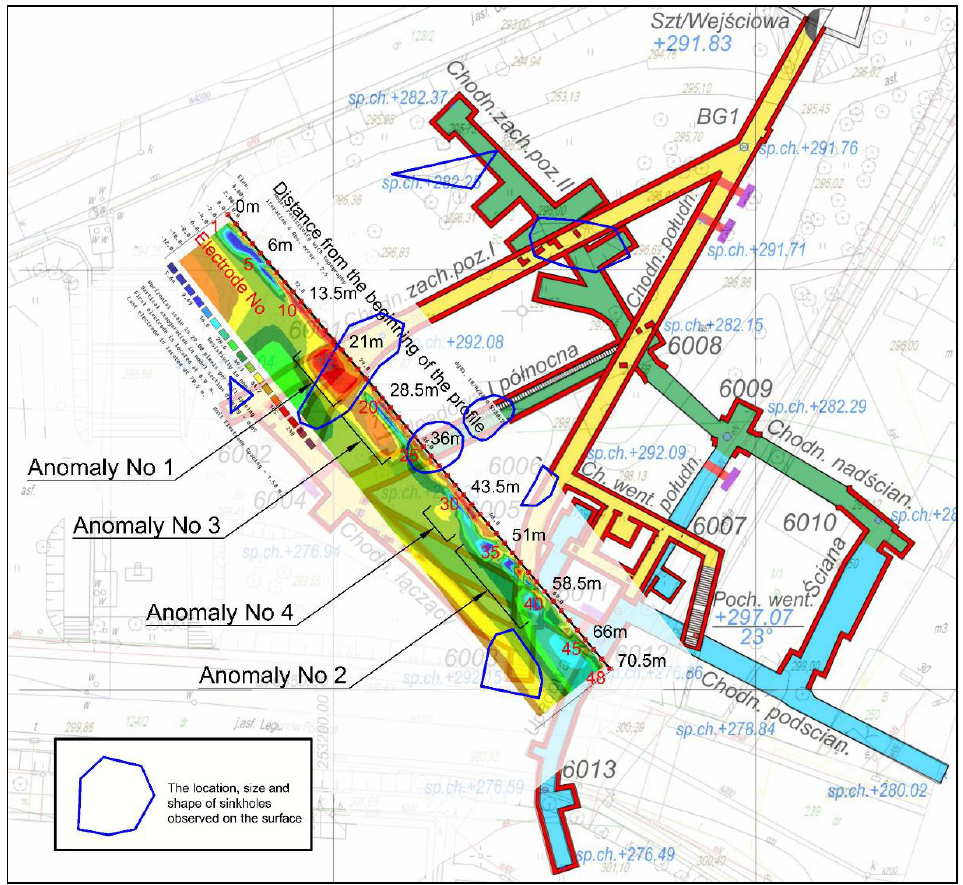
Figure 18. The location of the resistivity anomalies along the ERT profile (measurement with the Dipole–Dipole array) against the workings and the sinkholes recorded during the 2011